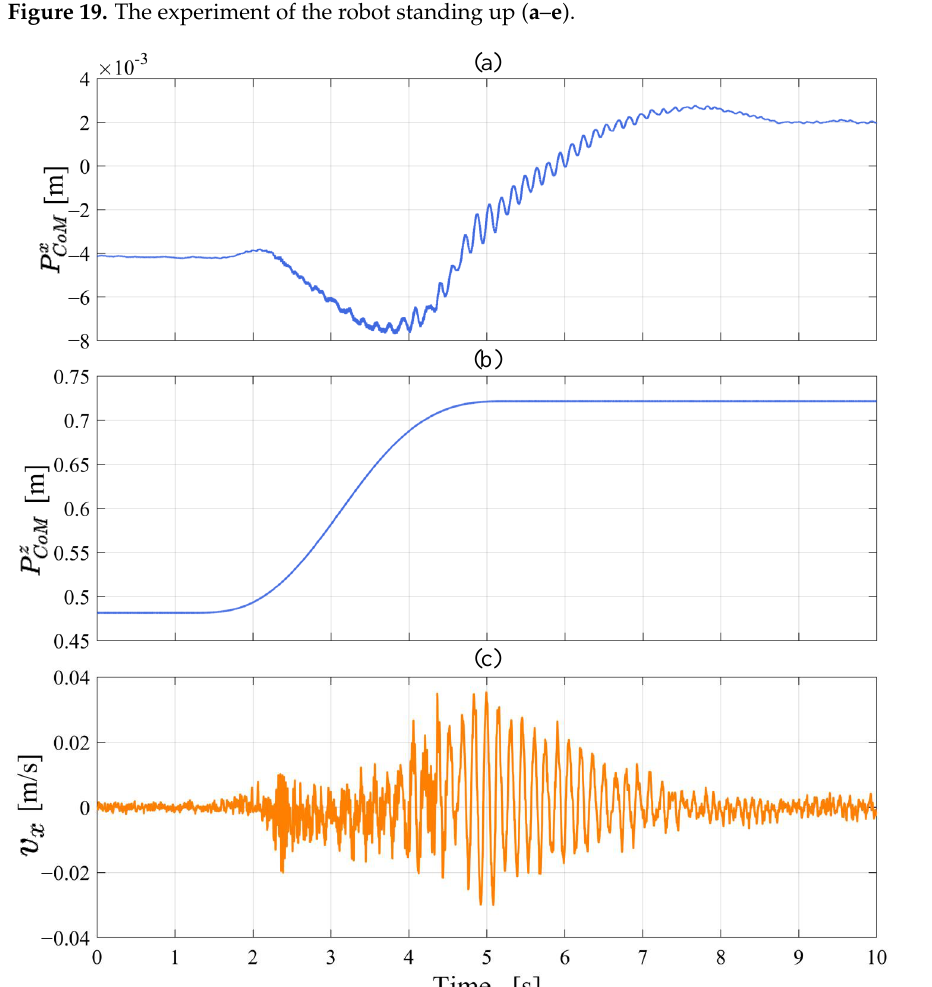
Figure 20. The position and velocity data of the CoM relative to the coordinate system ∑ w during standing up ( a – c